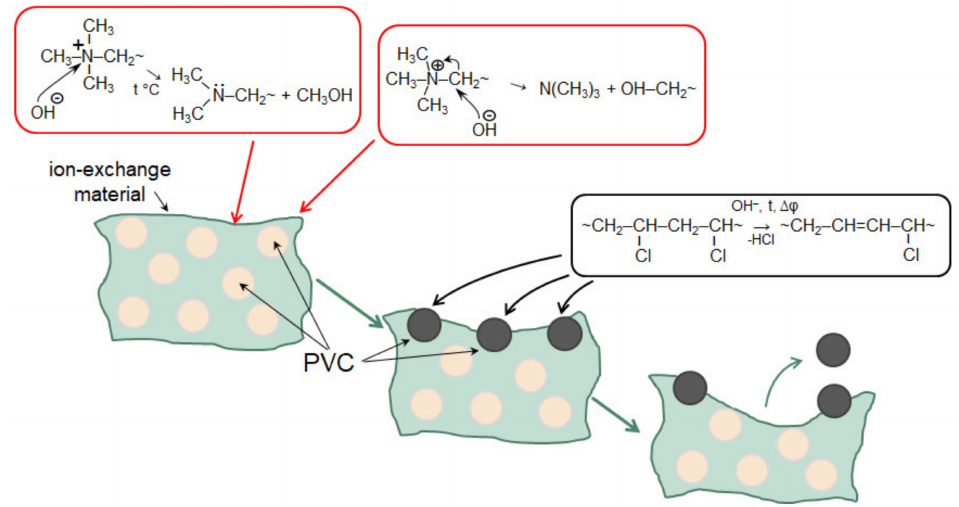
Figure 23. Schematic representation of the degradation of anion-exchange membranes produced by the paste